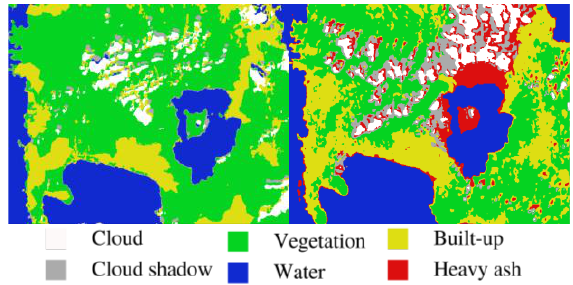
Figure 3. Image classification of Diwata-2 satellite images taken before (left) and after (right) the Taal volcano eruption